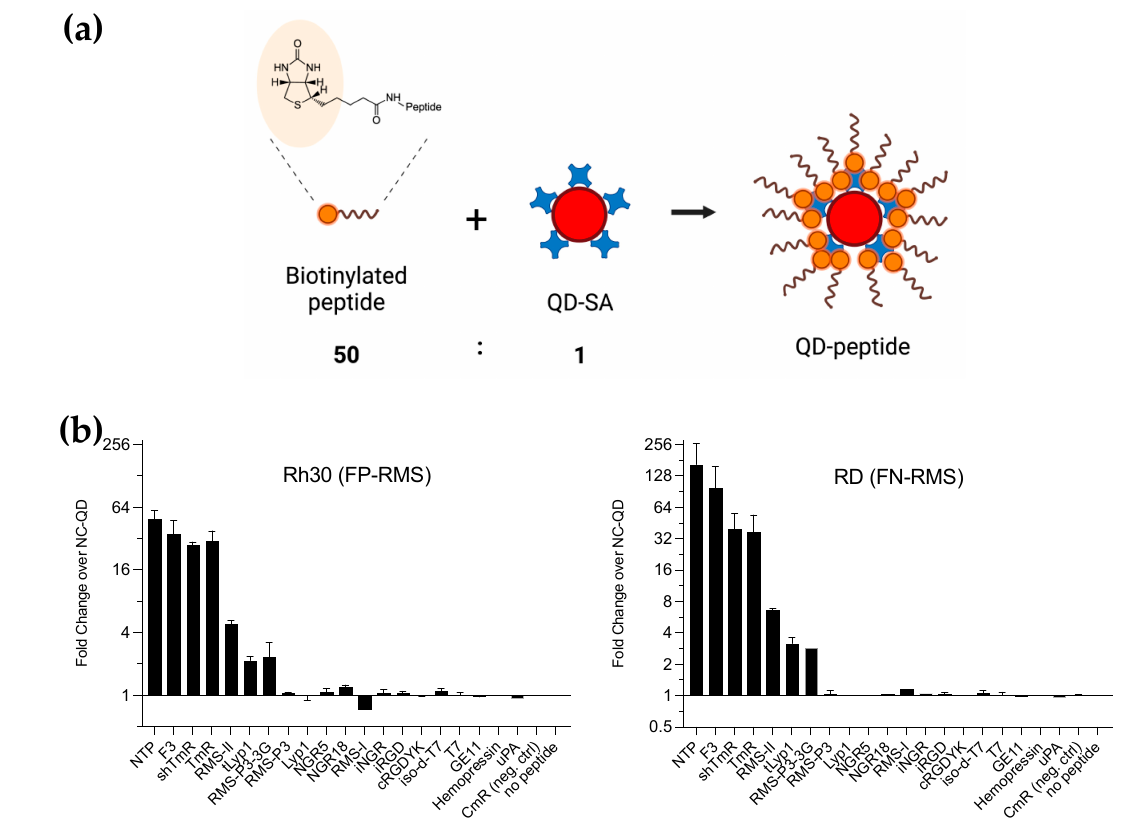
Figure 1. Scheme of QD-peptides conjugates’ preparation and binding to RMS cells. ( a ) Biotinylated peptides are incubated with QD-SA (605 nm) at a molar ratio of 50:1. After incubation, unbound peptides are removed by size exclusion chromatography with a 5 kDa cutoff. QD are expected to carry 5–10 Streptavidin (SA) molecules and can therefore incorporate up to 15–30 peptides. The estimated size of labeled QD-peptides conjugates is around 10 nm. ( b ) Binding of the selected QD-peptides conjugates to RMS cell lines RD (FN-RMS) and Rh30 (FP-RMS) was measured by FACS. 100 ′ 000 RMS cells were detached with Accutase and incubated in suspension with 20 nM QD-peptides conjugates, or nonconjugated QD-SA as a control, for 1 h at 37 °C with Rh30 cells (left panel) and RD cells (right panel). The fold-binding was calculated as the ratio between the geometric fluorescent mean intensity (FMI) of cells incubated with QD-peptides conjugates and the FMI of non-conjugated QD-SA from three independent experiments.